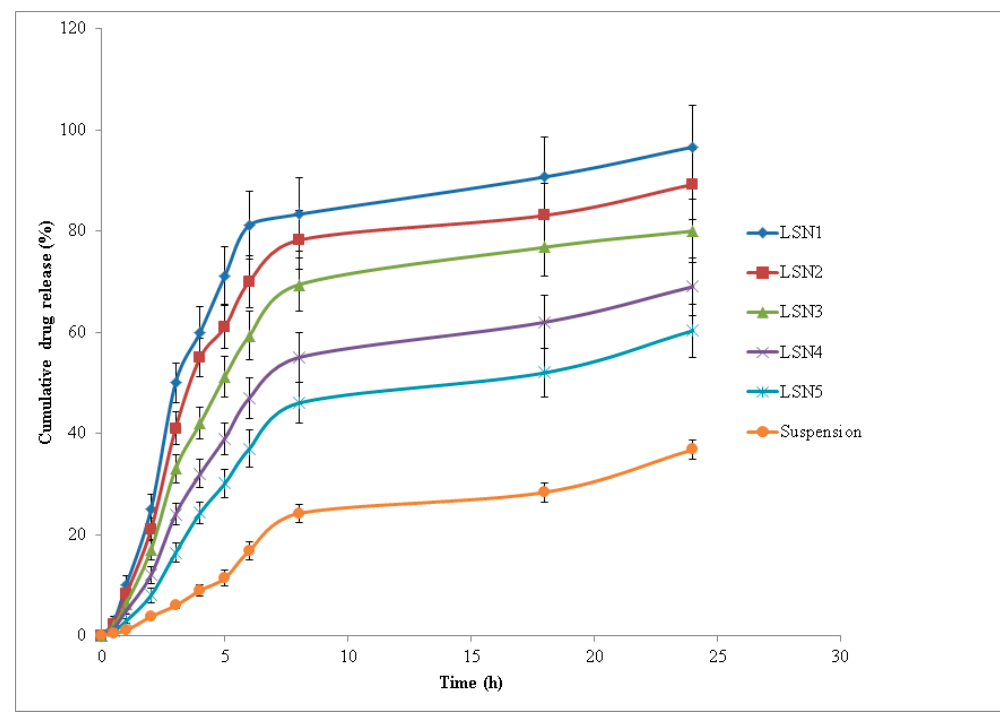
Figure 3. In vitro drug release profile of LUT via dialysis bag (mean ± SD, n = 3) from various SNEDDS (LSN1-LSN5) and aqueous suspension of LUT.